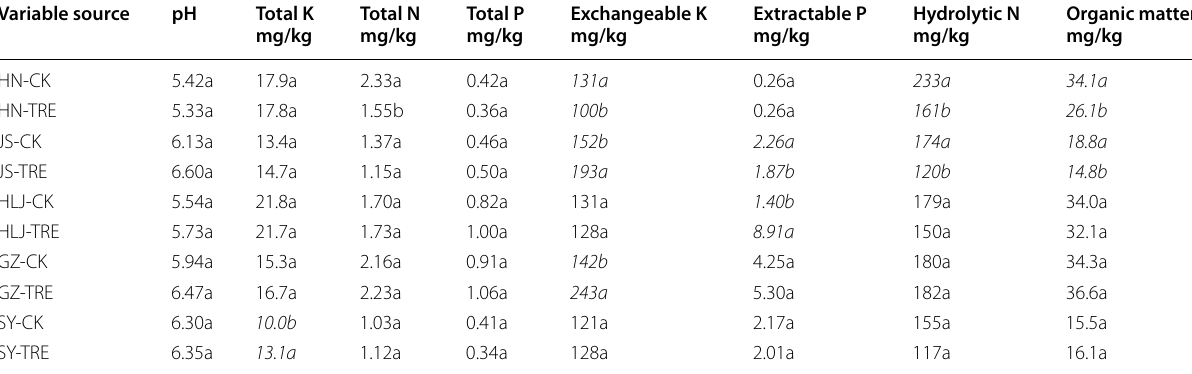
Italic values represent p < 0.05 Values show mean (n 3). Means with different letters represent significant differences at p < =